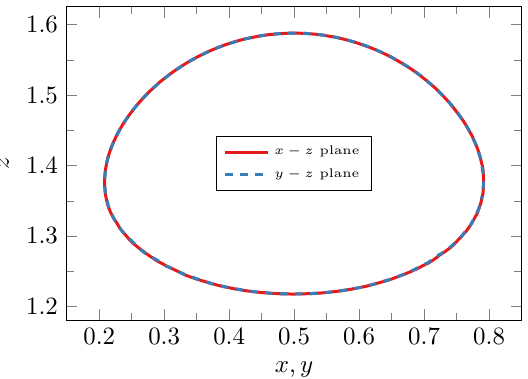
Figure 3. Shape at final time in the x - z and y - z planes for test case 1 ( h =